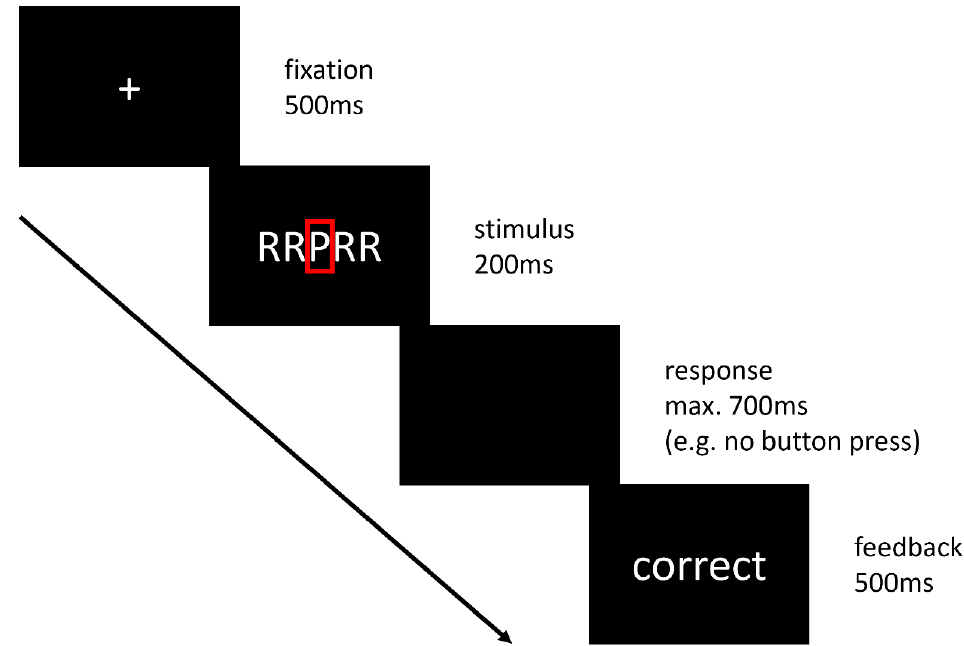
Figure 1. Erikson flanker Go/No Go paradigm as used during fMRI. The figure shows a sequence of an incongruent No Go trial as an example, starting from fixation until feedback. The No Go target letter ‘P’ is highlighted by a red rectangle only for demonstrational purposes (not shown during the real fMRI experiment). Durations of each trial segment are listed in milliseconds (ms).